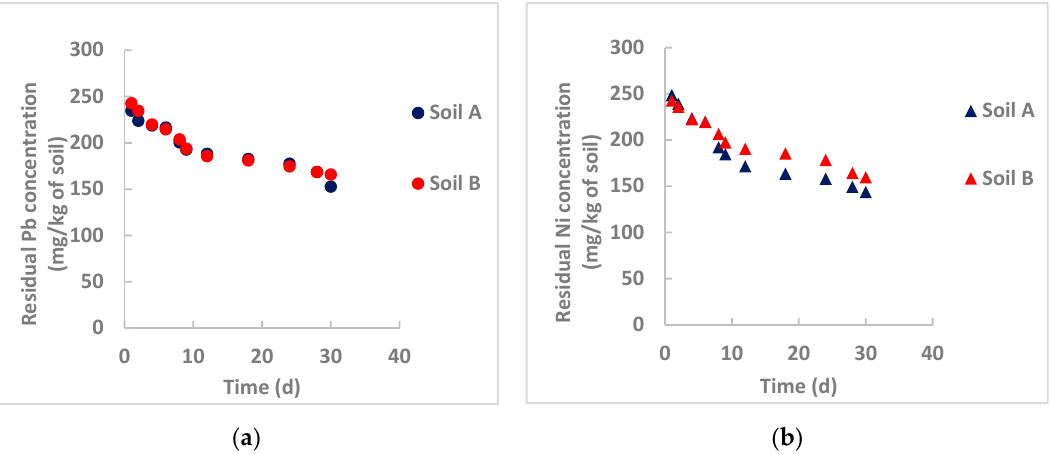
Figure 5. Remediation of nZVI particles synthesized using neem leaves (dosage: 0.2 g / kg of soil): ( a ) lead removal; ( b ) nickel removal.